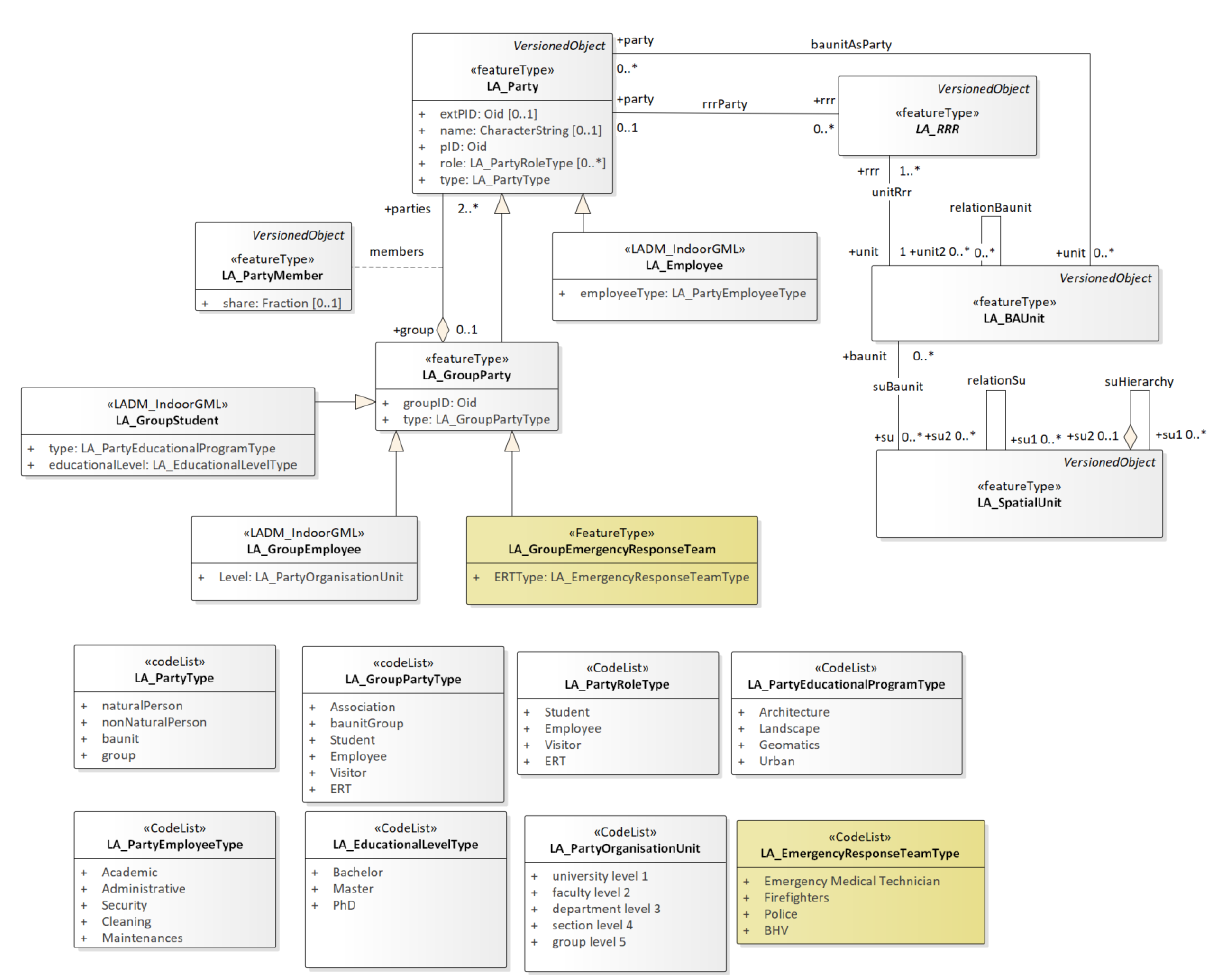
Figure 2. New subclass for the LA_GroupParty class and code list